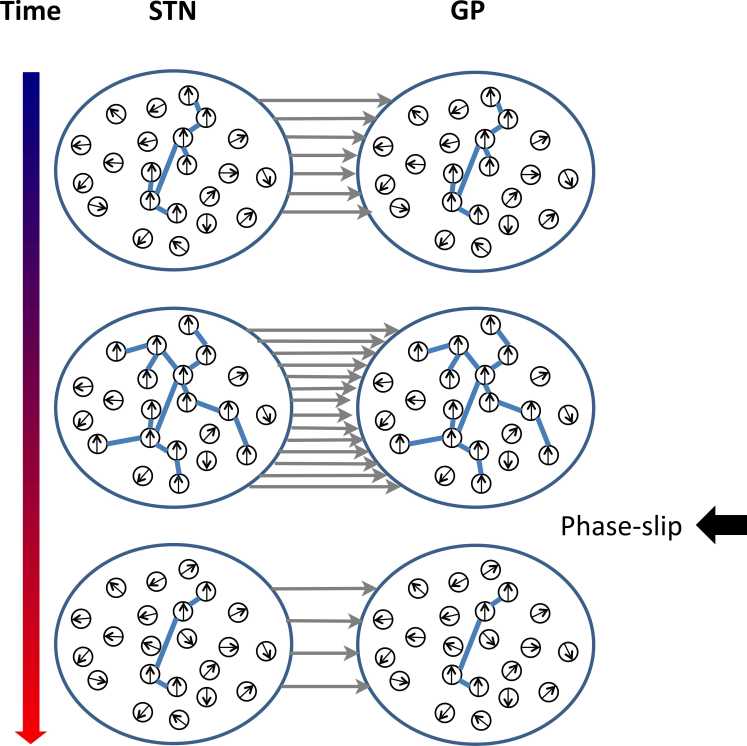
Phase alignment between oscillatory circuits is thought to optimize information flow, but excessive synchrony within the motor circuit may impair network function. Cagnan et al. characterize the processes that underscore excessive synchronization and its termination, as well as their modulation by levodopa, before suggesting interventions that might prevent pathological circuit interactions.